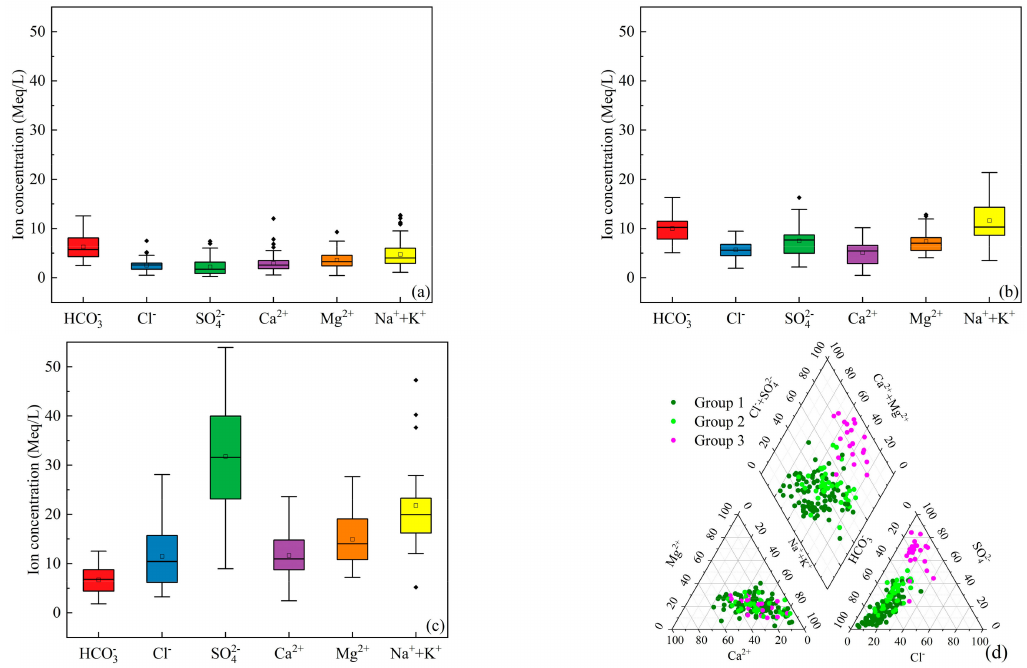
Figure 5. Box diagram of main physical and chemical indicators of cluster group (( a – c ) represent the groundwater ion concentrations of G1, G2, and G3, respectively) and Piper diagram ( d